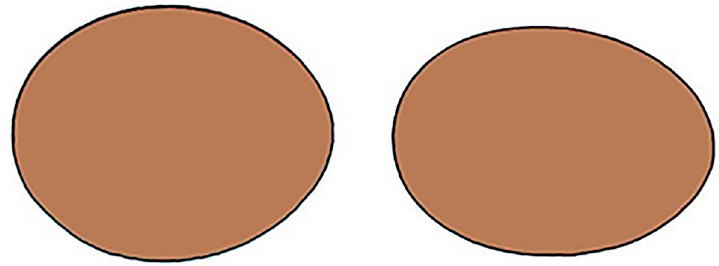
Figure 1. Oval shape egg for female chicks (left) and pointed shape egg for male chicks